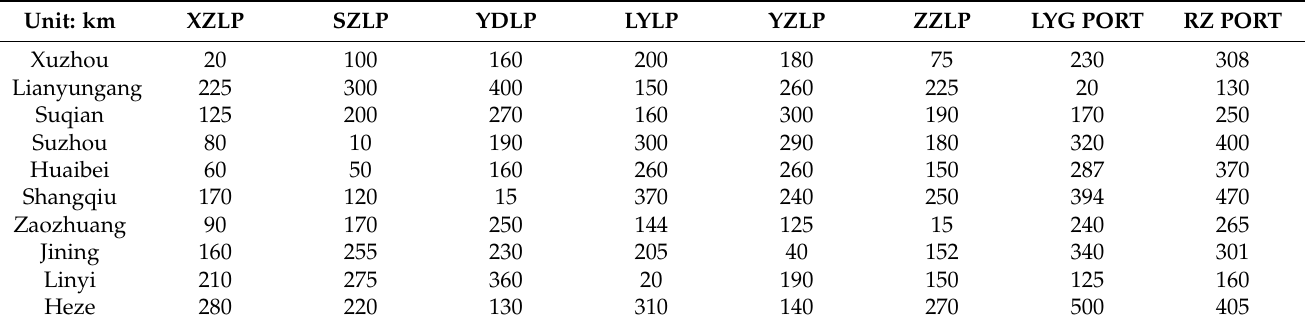
Table A1. Transport distance from origin city to domestic logistics parks/domestic seaports by road.